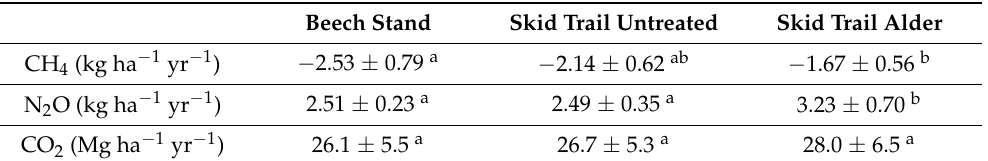
Table 2. Median values of cumulative CO 2 , N 2 O and CH 4 fluxes and their 95% confidence interval. Different letters indicate significant differences between treatments.